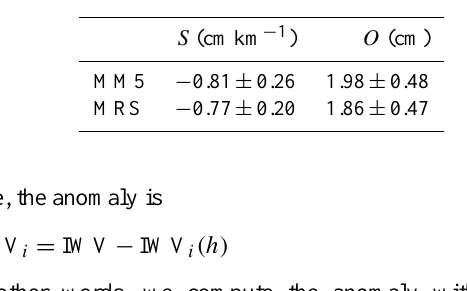
Fig. 7. Statistics of MM5 vs. MERIS IWV maps for all the match- up cases during the WVIOP. Table 3. Slope ( S ) and offset ( O ) of the IWV vs. height linear fit as extracted from the MERIS-MM5 IWV match-ups cases. The num- bers after ± indicate 95% confidence interval.